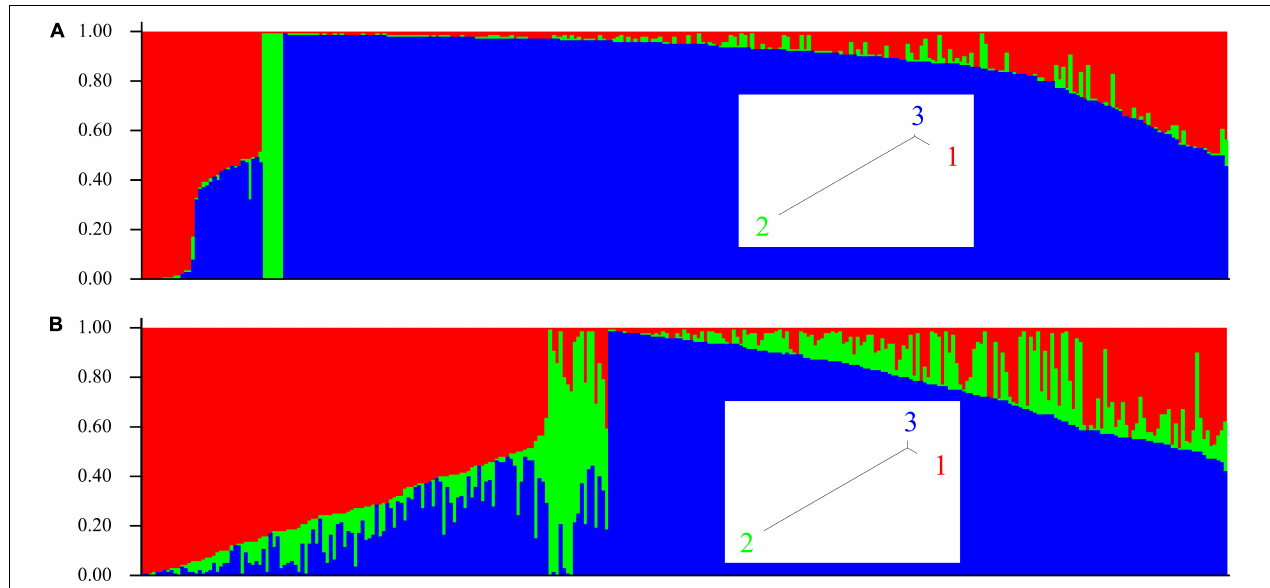
FIGURE 4 | Population structure of A. fabae isolates collected in Australia using the program STRUCTURE. (A) SNP and (B) SilicoDArT genotype data. Inset, tree view from STRUCTURE for SNP and SilicoDArT genotype-based